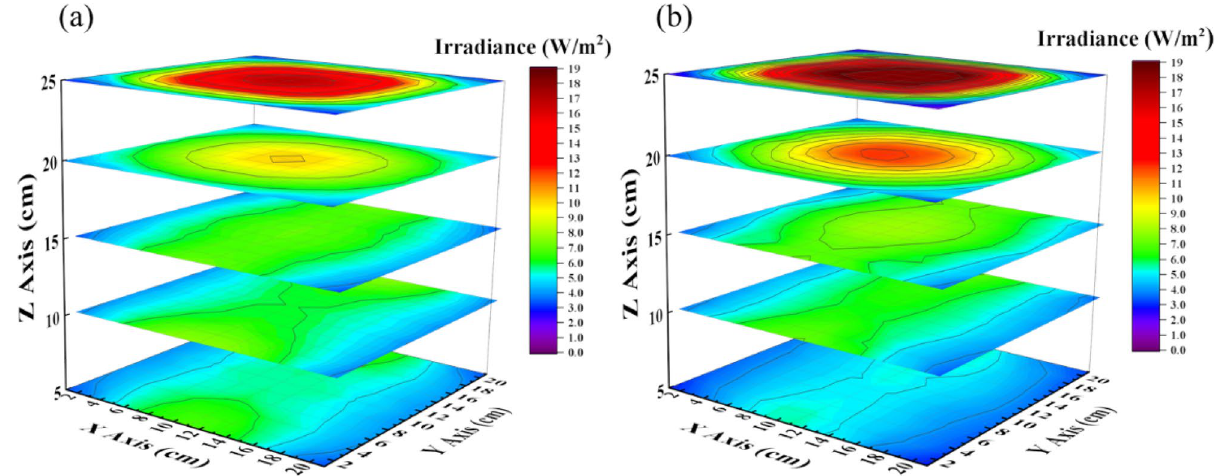
Figure 5. The light pattern of the section at different positions in ( a ) simulation, and ( b ) experiment; the section receive light from the top surface illuminating downwards and from the